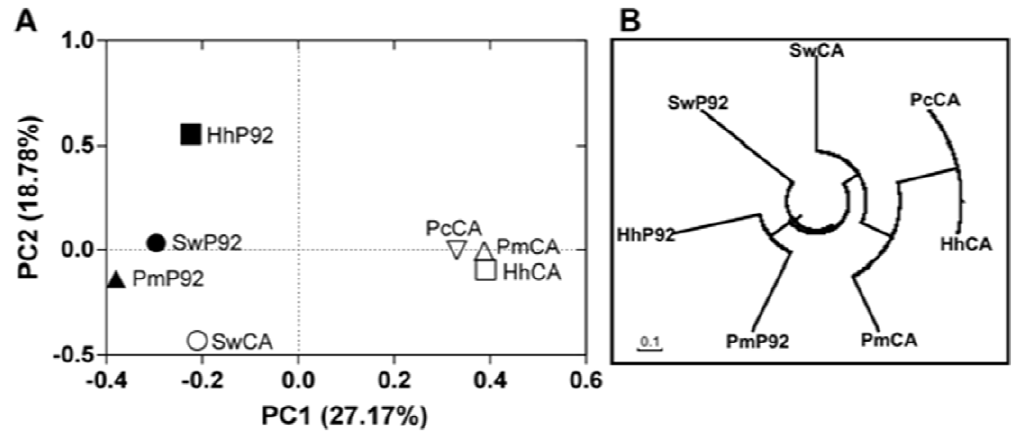
Figure 6. Match between archaeal communities in sponges and seawater samples. (A) Similarity between archaeal communities. Principal coordinates plots (PCA) were generated using the pairwise unweighted UniFrac distances. (B) Community tree showing the similarity of the samples under the Yue & Clayton theta structural diversity measure. Hh, Hymeniacidon heliophila ; Pm, Paraleucilla magna ; Pc, Petromica citrina ; SW, seawater; CA, Cagarras Archipelago; P92, inner bay site.